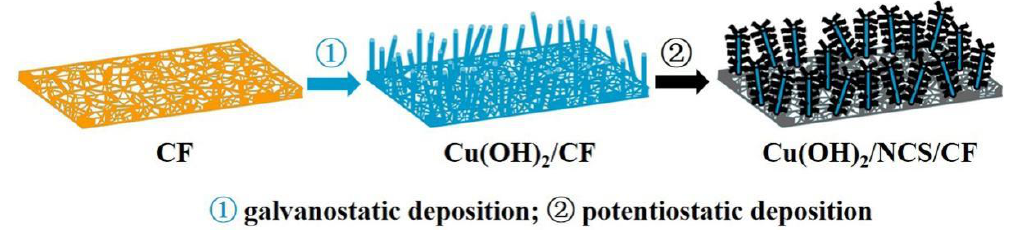
Figure 1. Synthesis path of hierarchical Cu(OH) 2 /NCS electrode.